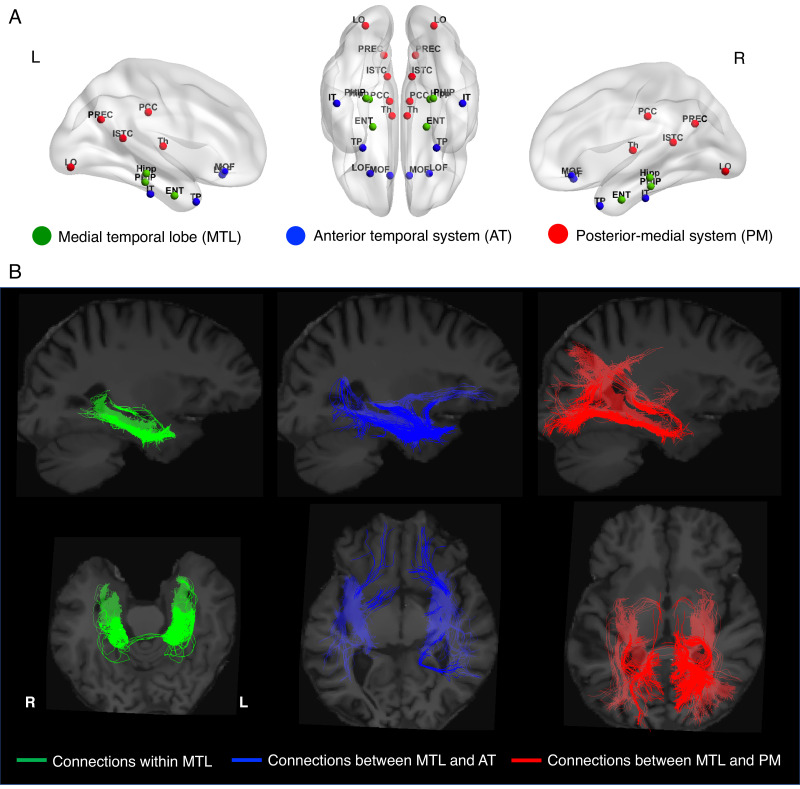
Regions of interests.(A) Regions of interests are identified based on the Desikan-Killiany Atlas and visualized with the BrainNet Viewer (Xia et al., 2013). The medial temporal lobe (MTL) includes bilateral entorhinal cortex (ENT), hippocampus (HIP), and parahippocampal gyrus (PHIP). The anterior-temporal (AT) system includes bilateral inferior temporal cortex (IT), temporal pole (TP), and lateral and medial orbitofrontal cortex (LOF/MOF), while the posterior-medial (PM) system includes bilateral posterior and isthmus cingulate (PCC/ISTC), lateral occipital cortex (LO), precuneus (PREC), and thalamus (TH). (B) Visualization of connections between MTL-related structures in a representative participant with TractVis (Wang and Wedeen, 2007).